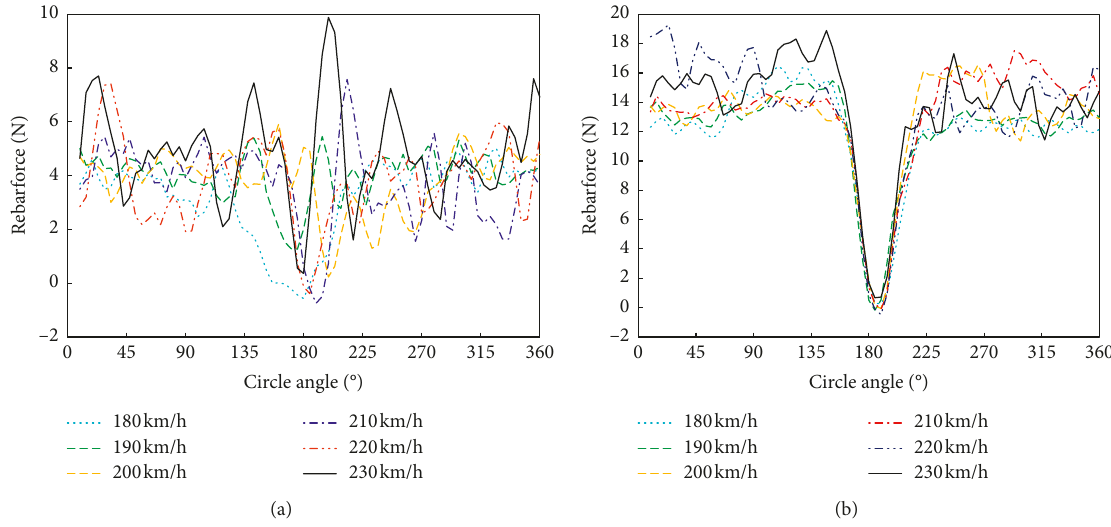
Figure 11: Circumferential distribution of carcass cord stress at different velocities. (a) Circumferential stress on the turn-up point of the carcass layer (point A). (b) Circumferential stress on the sidewall point of the carcass layer (point B).